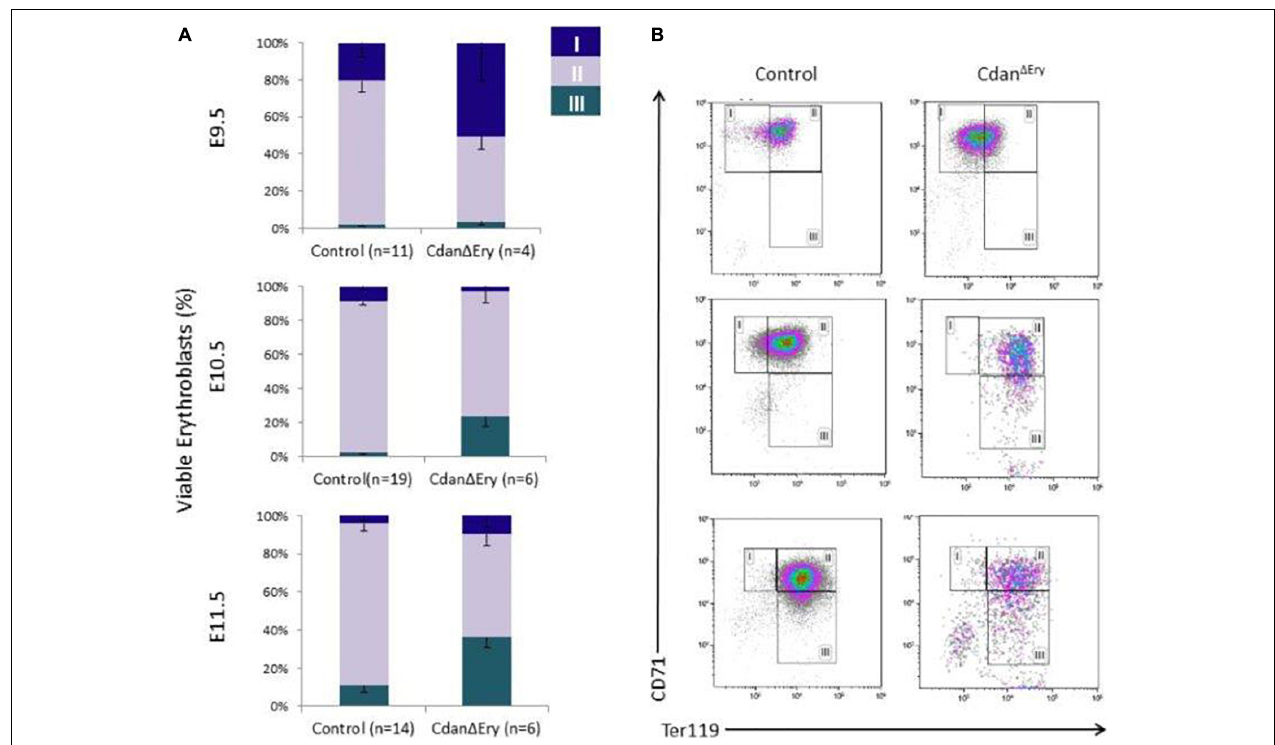
FIGURE 5 | Cdan1 is required for primitive erythroid differentiation. (A) Cdan (cid:49) Ery erythroblasts do not demonstrate the semi-synchronous maturation characteristic of primitive erythroblasts. Quantification of erythroid sub-populations represented as mean ± SEM. Sub-population were grouped by CD71/Ter119 surface expression according to the following: I – Ter119loCD71+; II – Ter119 + CD71 + ; III – Ter119+CD71lo. (B) Representative FACS profile of Cdan (cid:49) Ery peripheral blood erythroblasts compared to littermate